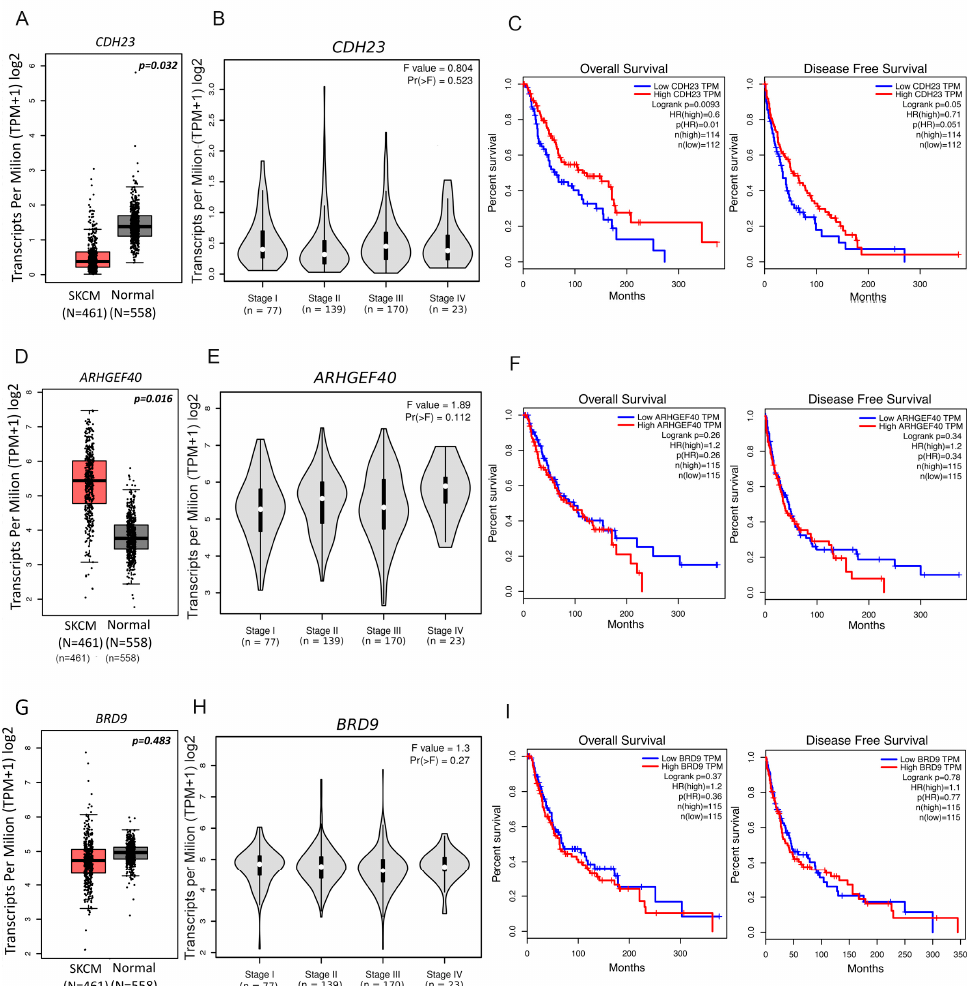
Figure 4. CDH23 , ARHGEF40, and BRD9 expression data from Gene Expression Profiling Interactive Analysis. Boxplots generated to compare gene expression levels between tumour and normal skin samples for ( A ) CDH23 , ( D ) ARHGEF40, and ( G ) BRD9 . Violin plots compare gene expression between tumour pathological stages for ( B ) CDH23 , ( E ) ARHGEF40, and ( H ) BRD9 . Expression data presented in log 2 (transcripts per kilobase million + 1). One-way ANOVA was used for di ff erential analysis. Overall survival and disease-free survival plots from high and low gene expressing tumour samples for ( C ) CDH23 , ( F ) ARHGEF40, and ( I ) BRD9 . Prognostic value was assessed using survival analysis from GEPIA program. Patients were divided in low and high expression groups based on median expression cut-off for each gene. Survival curves were analysed using the Cox PH model.